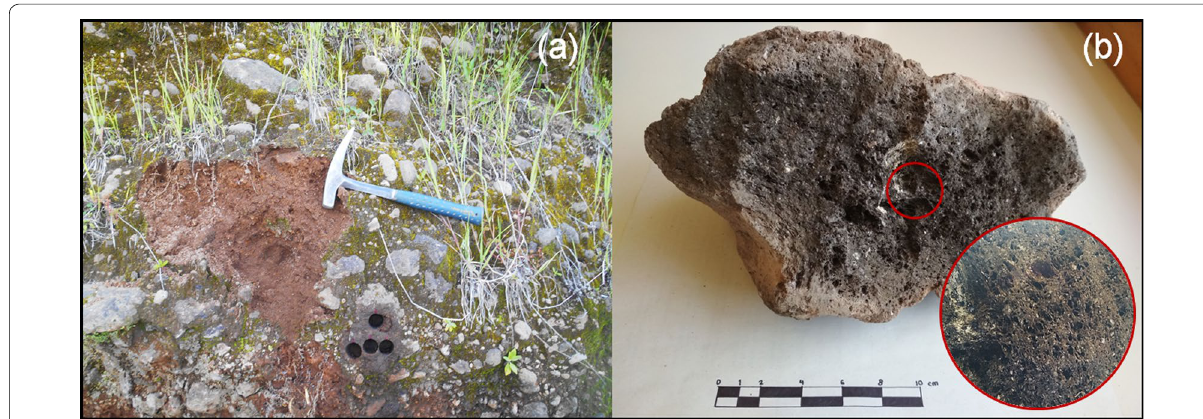
Fig. 4 a Photograph of the scoria clast (site PO‑1). b View of a scoria